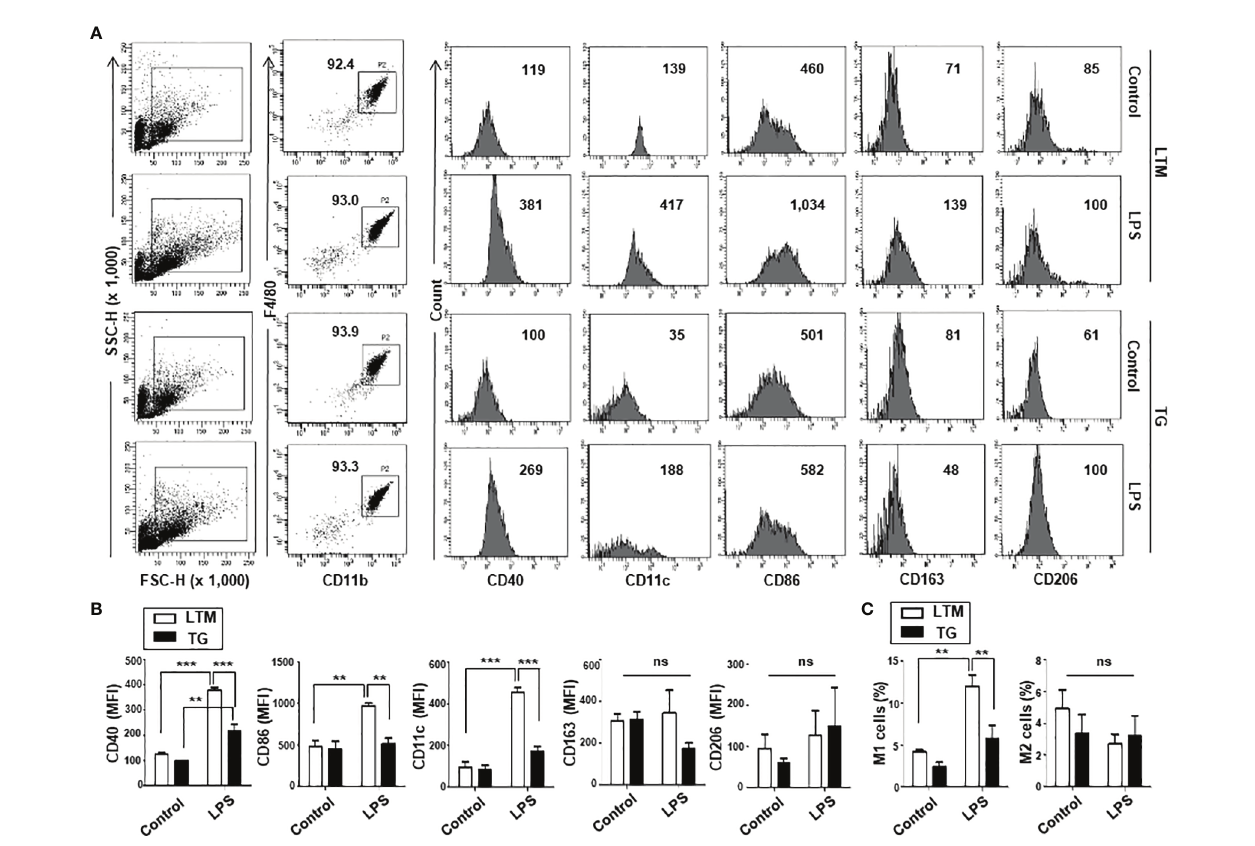
FIGURE 3 | Macrophage subset populations in LTM and TG mice. Analyses of subset populations of PMs from LTM and TG mice in normal conditions and during peritoneal in fl ammation caused by LPS. PMs were labeled with FITC- or APC-conjugated anti-CD11c, FITC-conjugated anti-CD40 or anti-CD86, BV421- or APC- conjugated CD163, APC-conjugated CD206 mAbs in color combinations, along with mAbs for PE-conjugated CD11b and PerCP-conjugated F4/80. Four-color fl ow cytometric analyses were then conducted. (A) Representative results are presented as dot plots, showing F4/80 vs. CD11b staining, and the percentages of the total cells that they represent are indicated. The expression of M1 markers (CD40, CD11c, CD86) and M2 markers (CD163, CD206) of CD11b + F4/80 + cells is shown as the mean fl uorescence intensity (MFI) of each marker. (B) The MFI of each marker is compared and the data from three independent experiments are presented as the mean ± SEM. Statistical signi fi cance was analyzed by one-way ANOVA with Tukey ’ s multiple comparison tests. Signi fi cant comparisons are noted as ** p < 0.01, *** p < 0.001, ns, not signi fi cant. (C) Changes in the M1/M2 subset population during peritoneal in fl ammation caused by LPS were compared as the percentage of CD11b + F4/80 + cells expressing CD11c (M1) and the percentage of CD11b + F4/80 + cells expressing CD163 (M2). Data shown are the mean ± SEM of three separate analyses. Signi fi cance was determined by one-way ANOVA with Tukey ’ s multiple comparison tests (** p < 0.01, ns, not signi fi